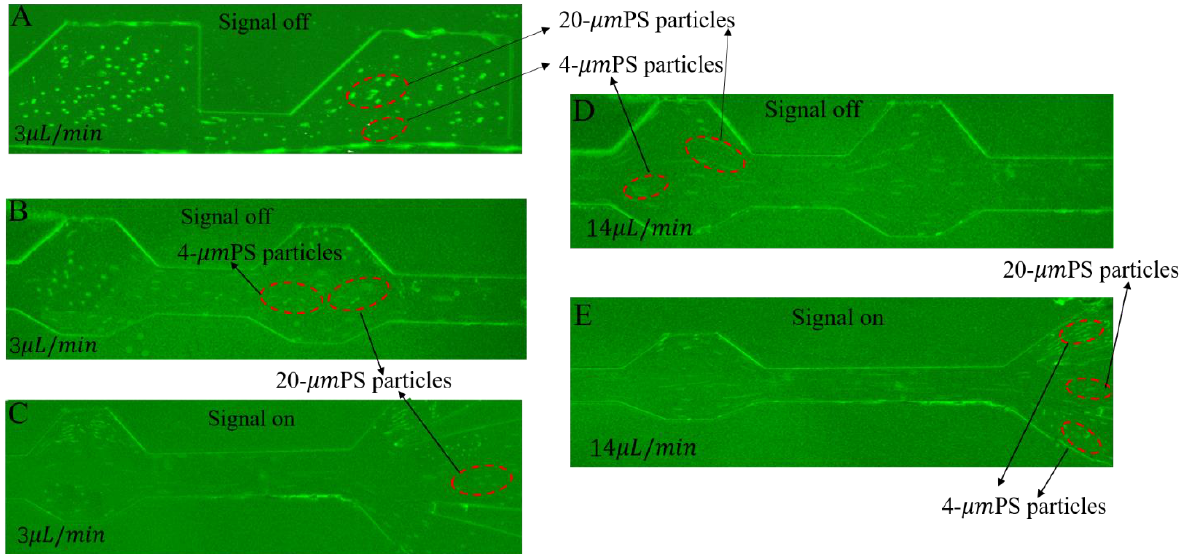
Figure 7. ( A ) Particle trajectory near the inlet at 3 µL/min without signal applied. ( B ) Particle trajectory near the outlet at 3 µL/min without signal applied. ( C ) Particle trajectory at 3 µL/min with 5 V signal applied. ( D ) Particle trajectory at 14 µL/min without signal applied; ( E ) Particle trajectory at 14 µL/min with 5 V signal applied .